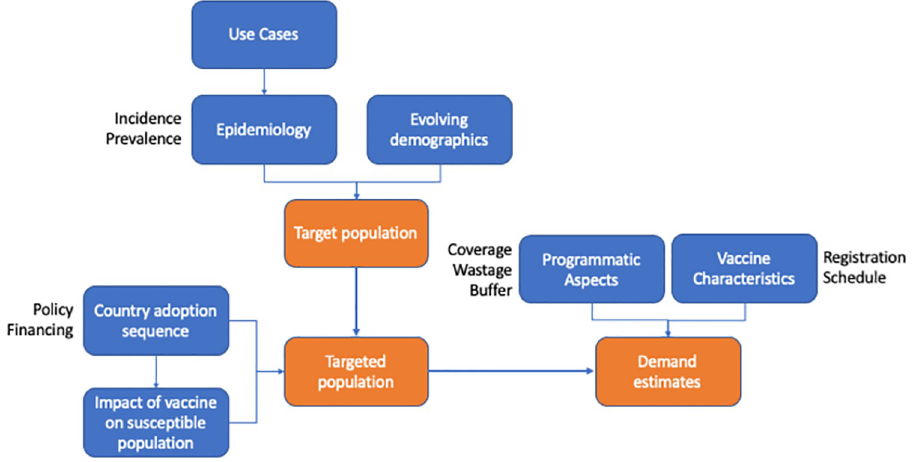
Fig 1. Logical framework of the demand forecast